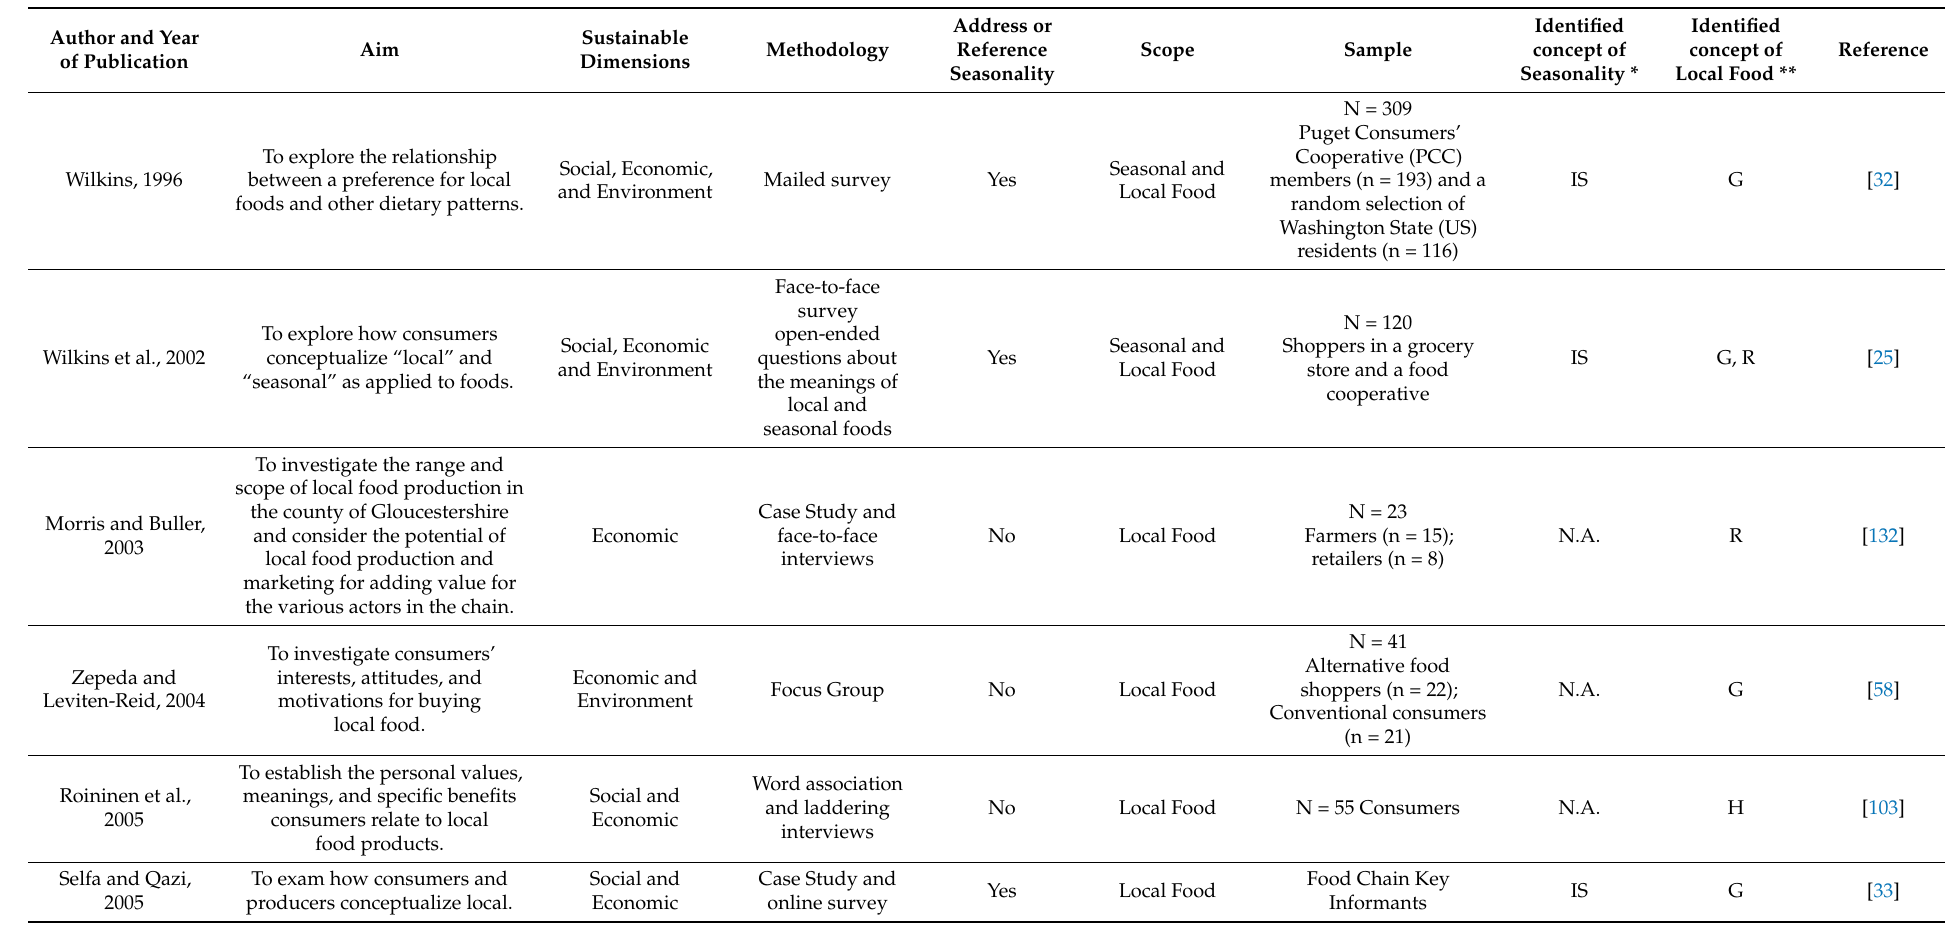
Table A1. List of articles analyzed in the systematic review regarding local and seasonality concepts, ordered by publication